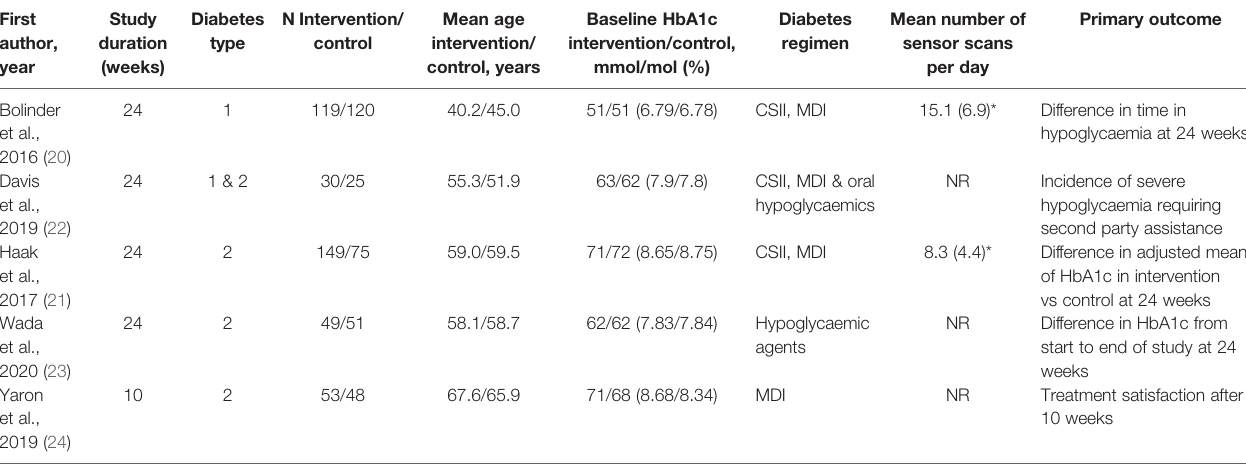
TABLE 1 | Characteristics of studies included in the